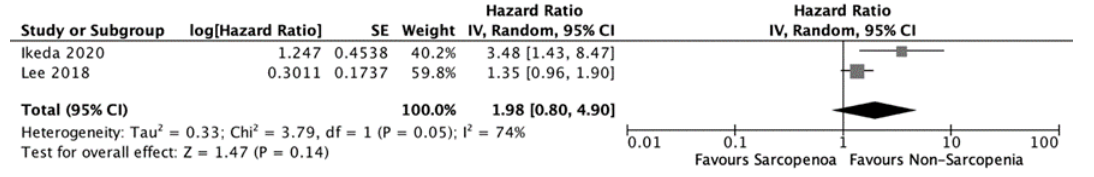
Figure 3. Forest plot for cancer-specific survival — Univariate Analysis [20,21].